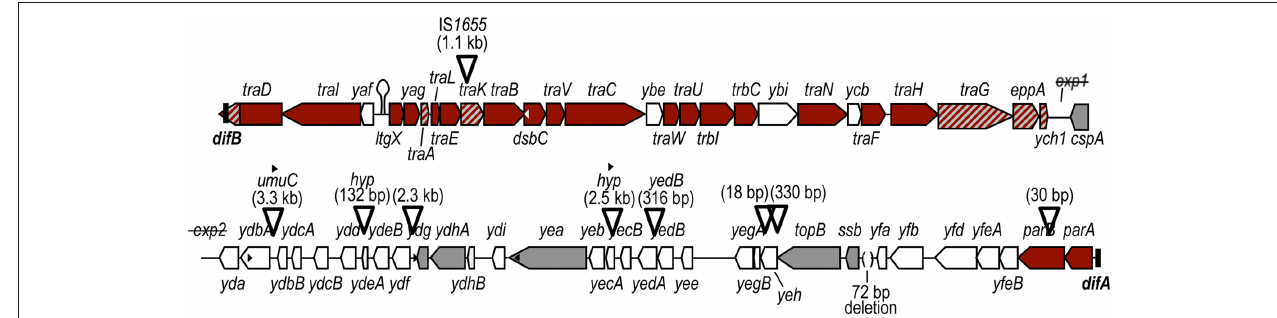
and difB is contained within the traD coding region. This GGI contains the long allele of traA , and IS 1655 is inserted just after the start codon of traK . A truncated allele of traG is present followed by the hypothetical endopeptidase eppA (also found in some gonococci). There is a deletion of exp1 . The α 275 GGI also has an insertion of partial DNA polymerase V subunit umuC at ydbB and an insertion of partial yedB at yedA . A small deletion upstream of ssb is indicated by parentheses. DNA uptake sequences (DUS) are indicated by small black or white triangles. In addition to the four DUS indicated in the figure, two DUS are located in the inserted sequences (black triangles over the